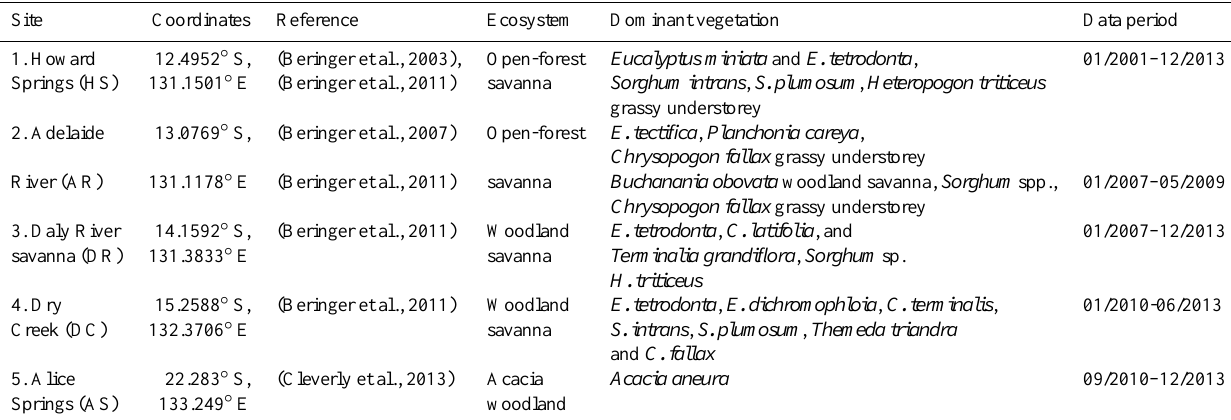
Figure 2. (a) Map of 1000 points representative of the study area, and locations of flux sites (red dots) for use in calibration/validation. Flux site abbreviations are given in Table 2. (b) Latitudinal variation in mean annual precipitation (1900–2013). (c) Latitudinal variation in fire frequency and fraction of fires occurring in the early part of the dry season (pre-August; 1989–2011). Each point represents a spatial average across ∼ 65 points lying within a latitude bin of width 0.57 ◦ , with error bars representing 1 standard deviation. Table 2. Locations and characteristics of OzFlux sites (after Hutley et al.,